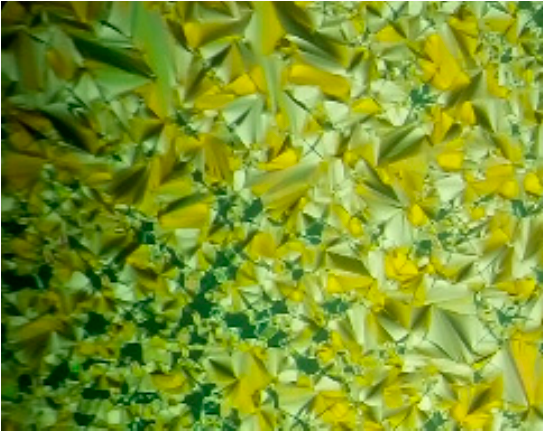
Figure 3. Polarized light microscopy (POM) SmA mesophase texture upon heating for 1:1 SMHBCs A16 / B14 at 180 °C .